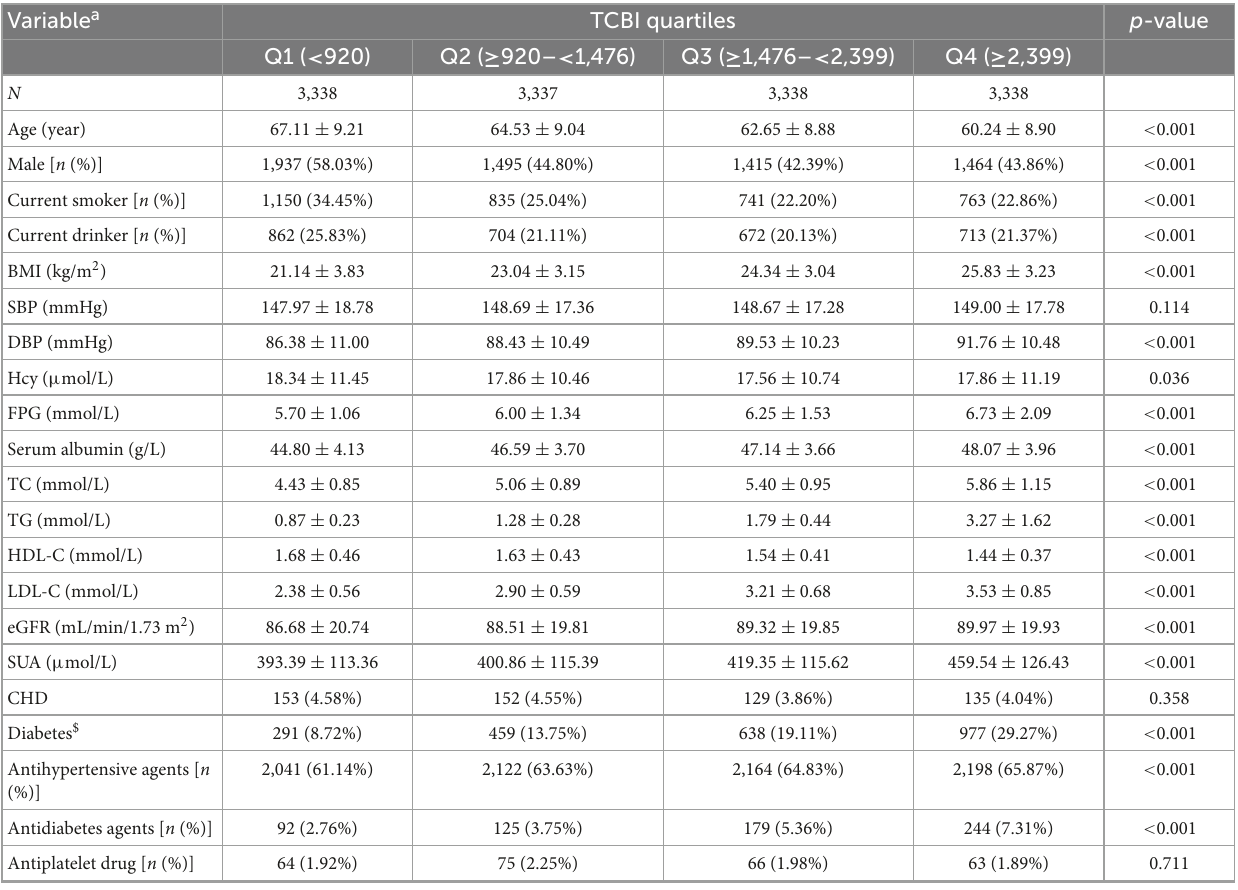
TABLE 1 Baseline characteristics of study participants by quartiles of baseline TCBI. Variable